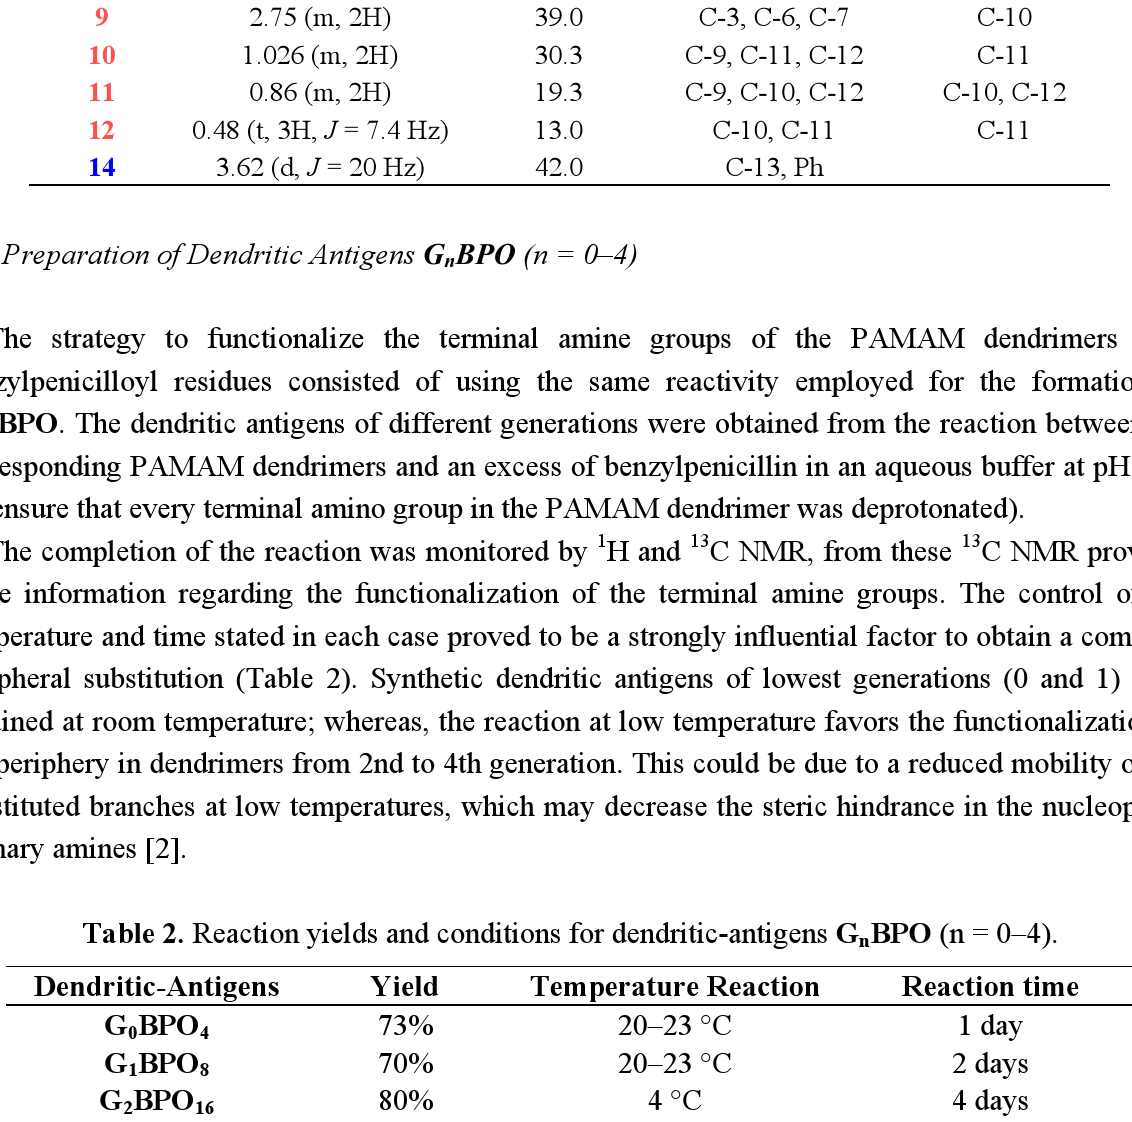
Table 2. Reaction yields and conditions for dendritic-antigens G